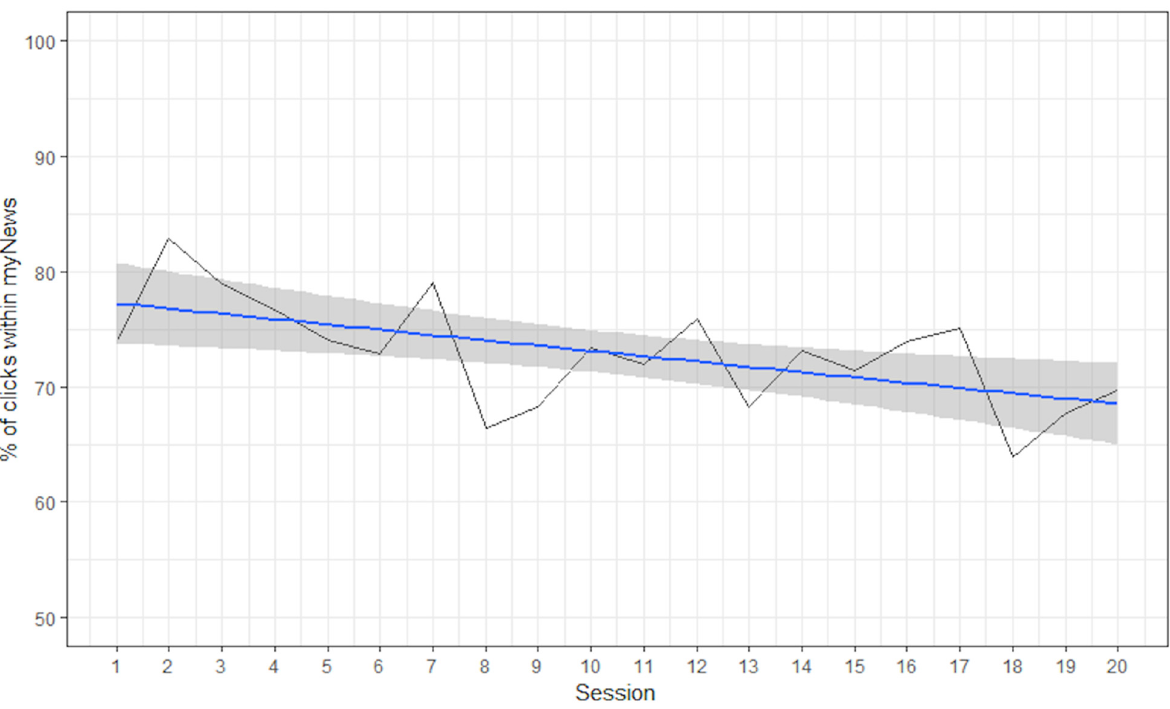
Figure 10. Distance between profile based ordinary user clicking behavior and MyNews outputs over time.